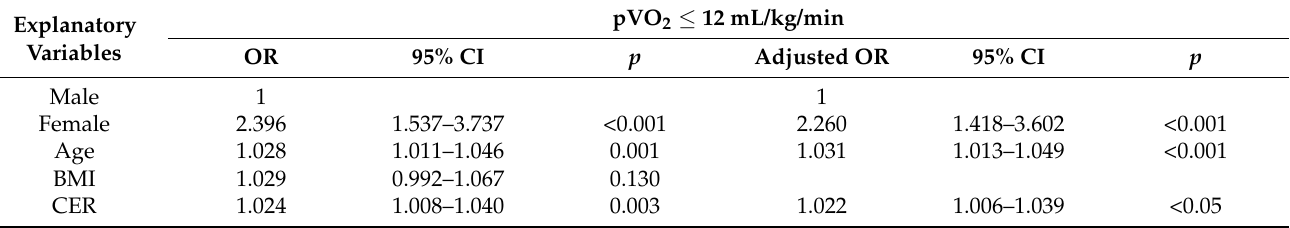
Figure 4. CER concentration in Weber class C and D, depending on VE/VCO2 results. The logistic model for prediction the value of pVO 2 ≤ 12 mL/kg/min revealed that CER as a continuous variable was an indicator of the poor test result. CER remains an independent predictor after adjustment for sex, age and BMI (Table 3). Table 3. Logistic regression analysis of CER, sex, age and BMI for pVO 2 value differentiation.